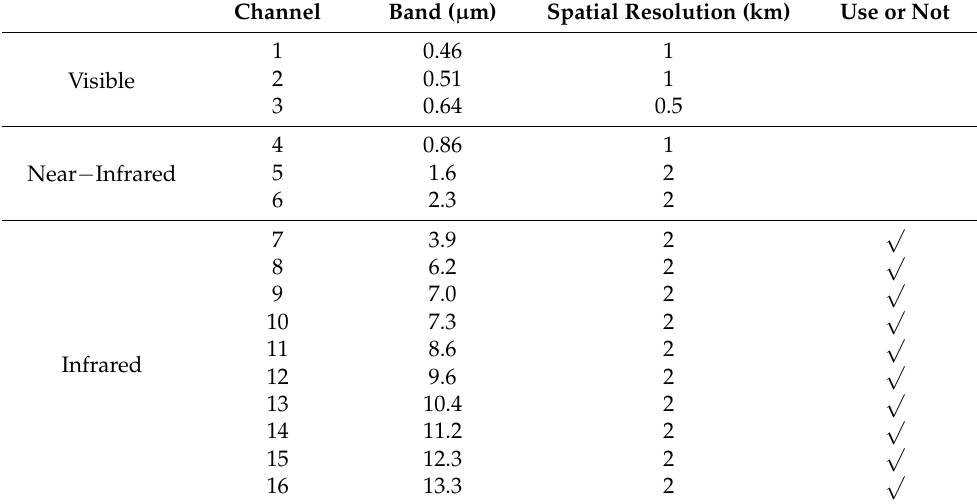
Table 1. Bands of